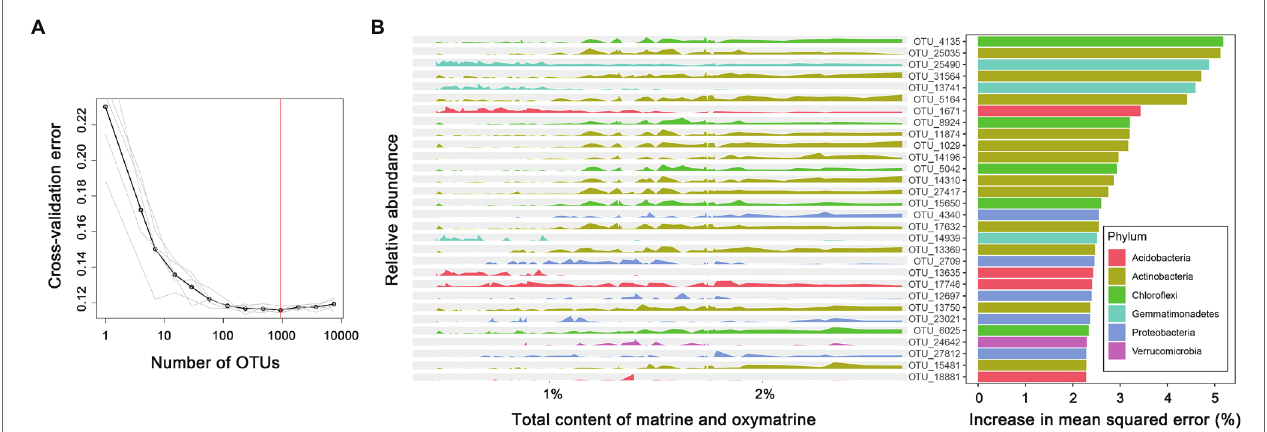
FIGURE 5 | The top 30 important bacterial markers associated with the total accumulation of matrine and oxymatrine in the roots of S. flavescens based on a random forest model. (A) The 10-fold cross-validation with five repeats generates 935 bacterial marker OTUs correlated with the total content of matrine and oxymatrine. (B) The peak map plotted according to the relative abundance of the top 30 marker OTUs against the total content of matrine and oxymatrine.